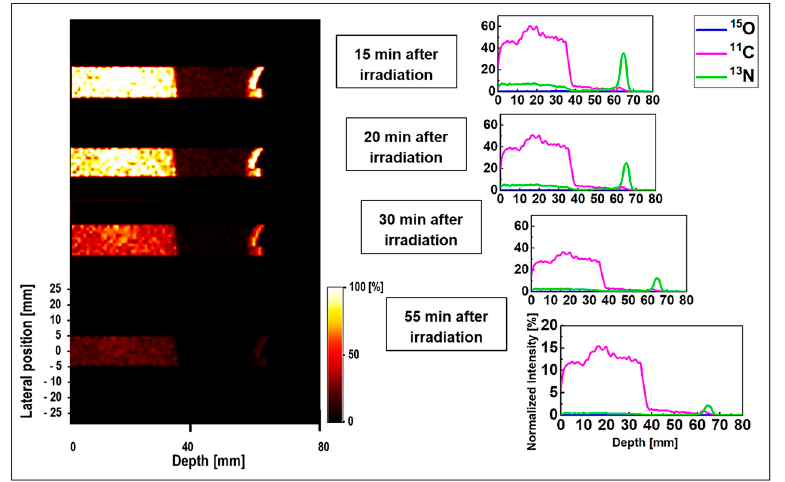
Figure 7. The 2D and 1D time-course activity analysis in the time range of 15 to 55 min for 15 O, 11 C, and 13 N positron emitting radionuclides in the MIRD anthropomorphic phantom irradiated 80 MeV monoenergetic proton beam.